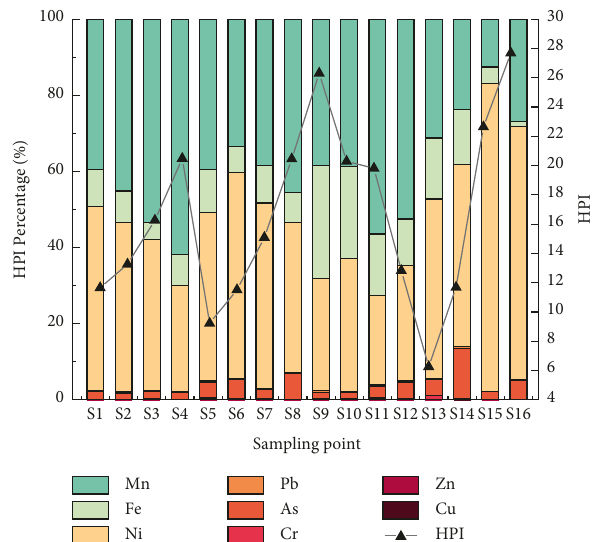
Figure 9: Changes of HPI at different sampling points of the subsidence water bodies and proportion of HPI of different heavy